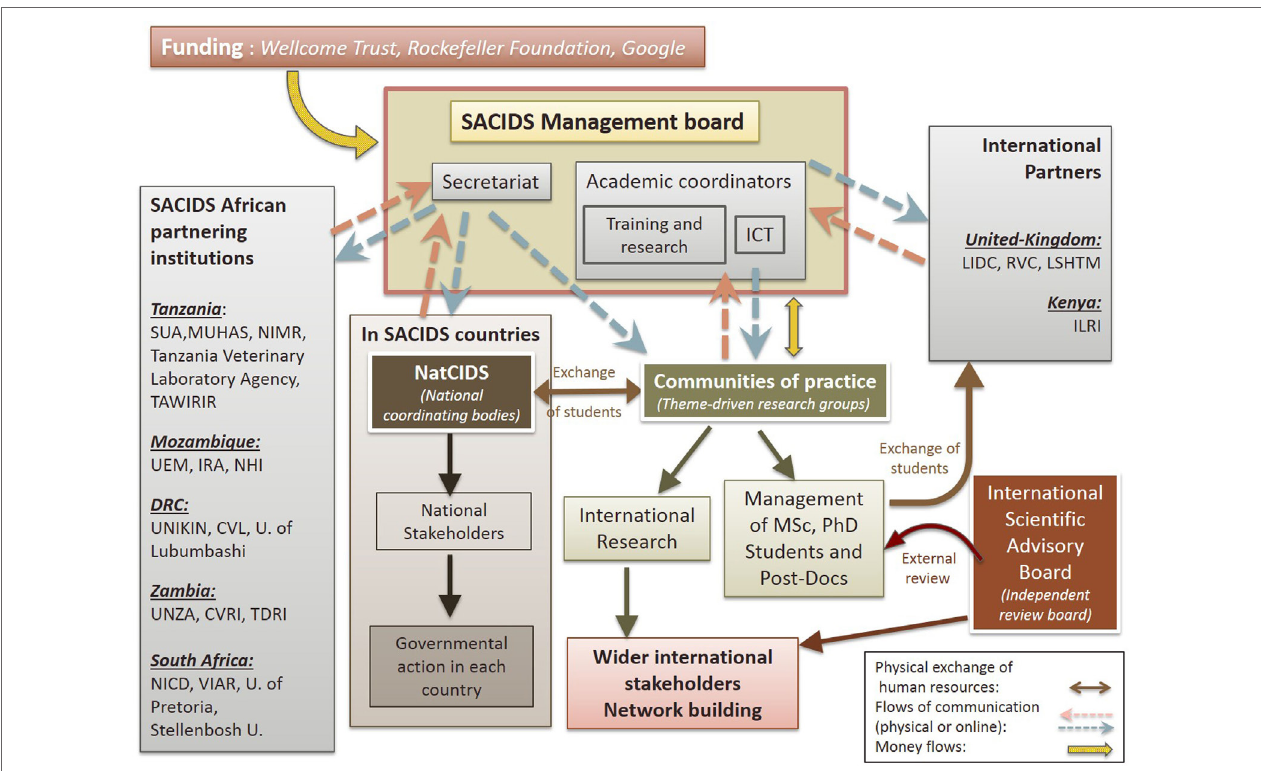
FigUre 4 | Interactions between Southern African Centre for Infectious Disease Surveillance (SACIDS)’ internal and external bodies. Abbreviations: SUA, Sokoine University of Agriculture; MUHAS, Muhimbili University of Health and Allied Sciences; NIMR, National Institute for Medical Research; TAWIRI, Tanzania